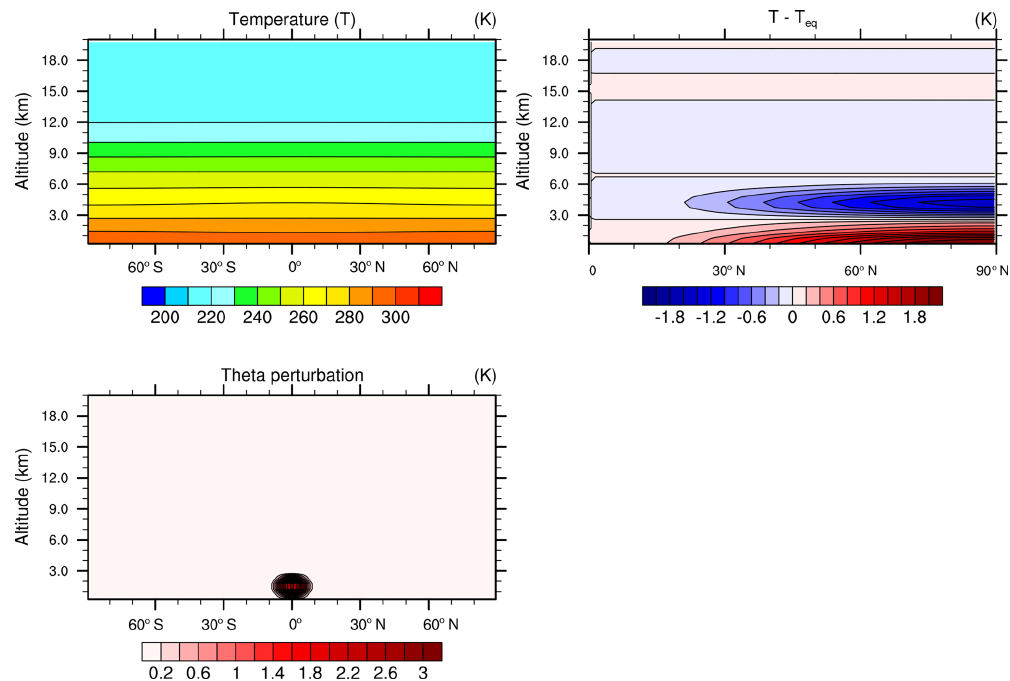
Figure 2. Same as Fig. 1 for temperature and potential temperature.